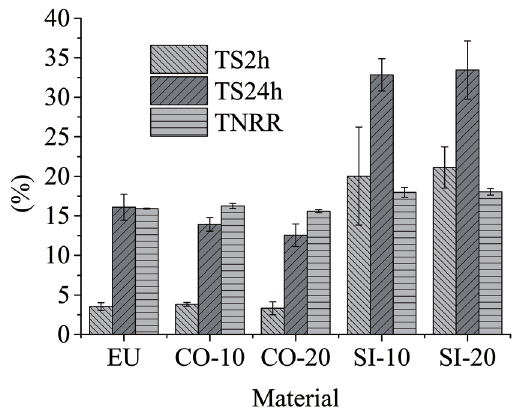
Figure 5: Histogram of the mean values for the thickness swelling after 2 hours (TS2h), thickness swelling after 24 hours (TS24h) and thickness non-return ratio (TNRR). Bars indicate standard deviation